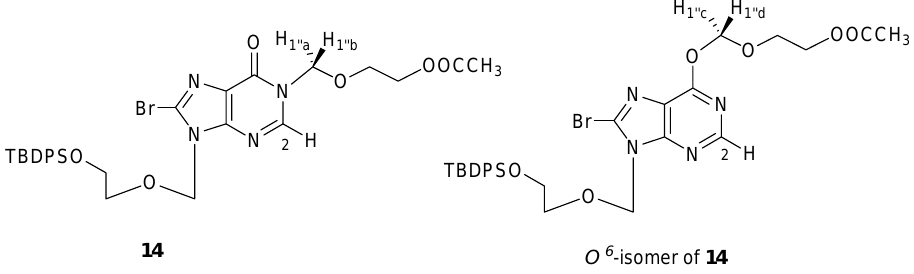
Figure 3. Structures of 14 and its O 6 -isomer.